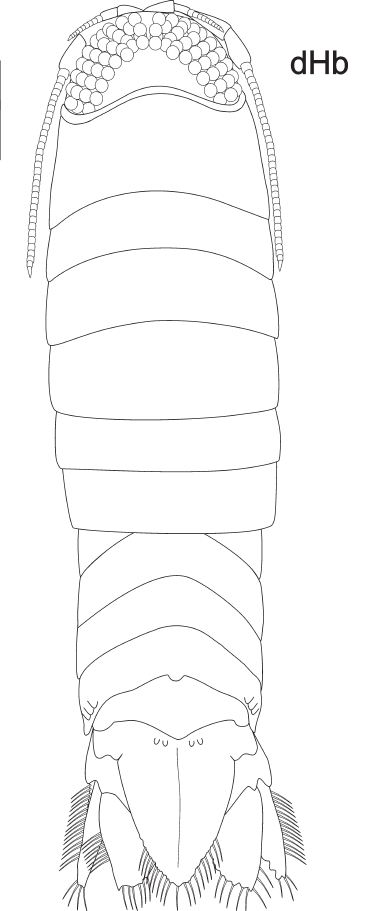
Figure 15. Excorallana warmingii (Hansen, 1890). Male, 10.2 mm. (MOUFPE 13.344), habitus. Scale = 1 mm.